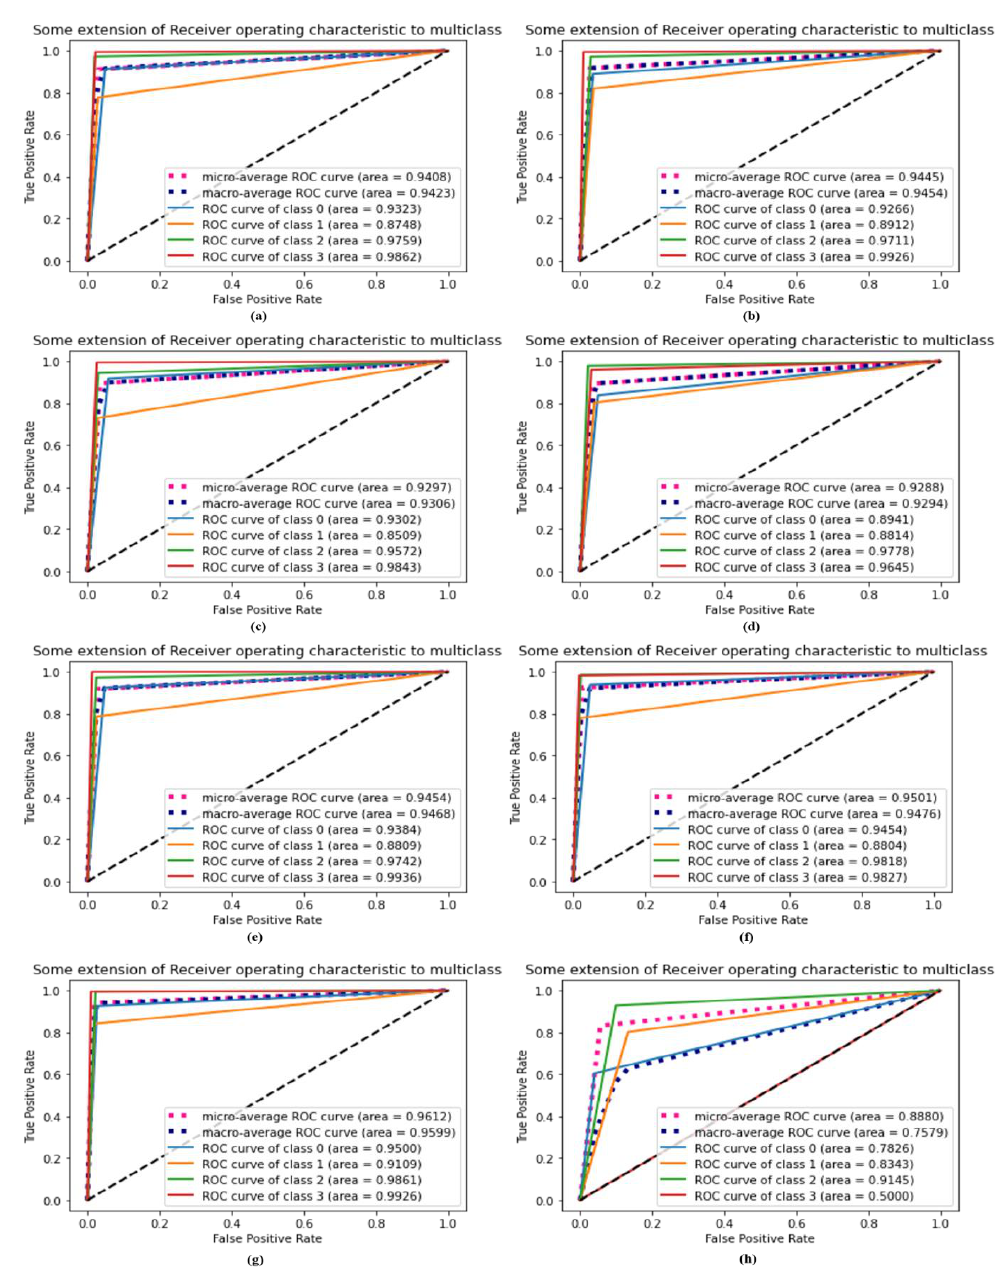
Figure 13. AU(ROC) curve evaluation with extension for the proposed model and other models; ( a ) Vgg-16, ( b ) Vgg-19, ( c ) EfficientNet-B0, ( d ) ResNet-152, ( e ) Inception-V3, ( f ) MobileNet, ( g ) Pro- posed Model with SMOTE Tomek, and ( h ) Proposed Model without SMOTE Tomek.